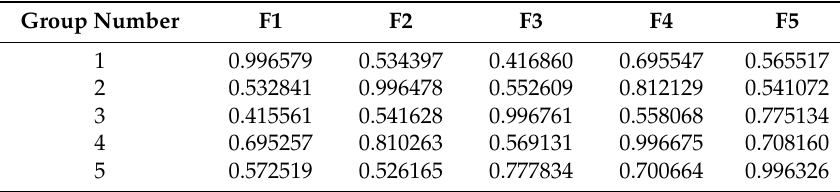
Table 14. Proposed method diagnosis